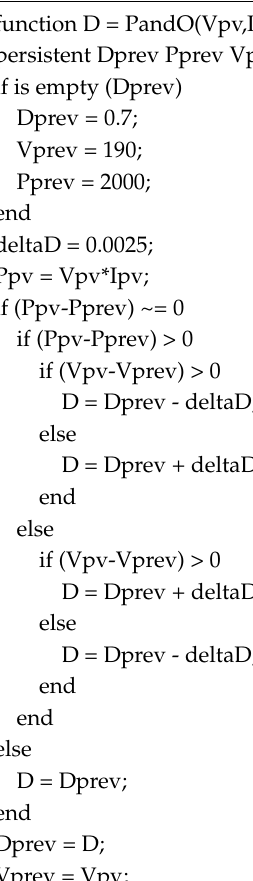
Figure 7. Flowchart of Perturb and Observation (P&O) Algorithm for MPPT. Algorithm 1. P&O MPPT